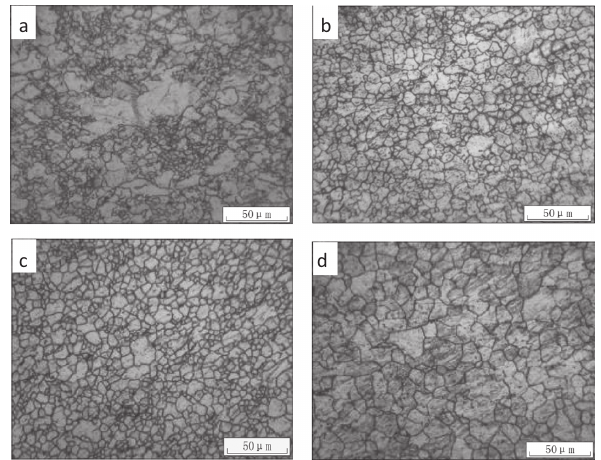
Figure 7: Microstructure characteristics of the hot deformed AZ81E alloys under different conditions: deformed at 400°C and 0.003 s – 1 (a), deformed at 400°C and 0.03 s – 1 (b), deformed at 400°C and 0.3 s – 1 (c), deformed at 430°C and 0.3 s – 1